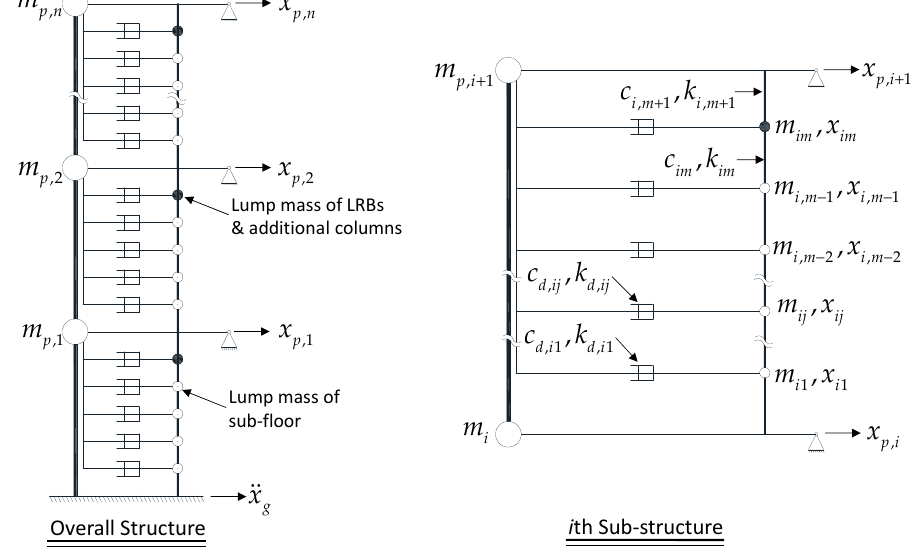
Figure 4. Lumped-mass model for MSCSS with LRBs.